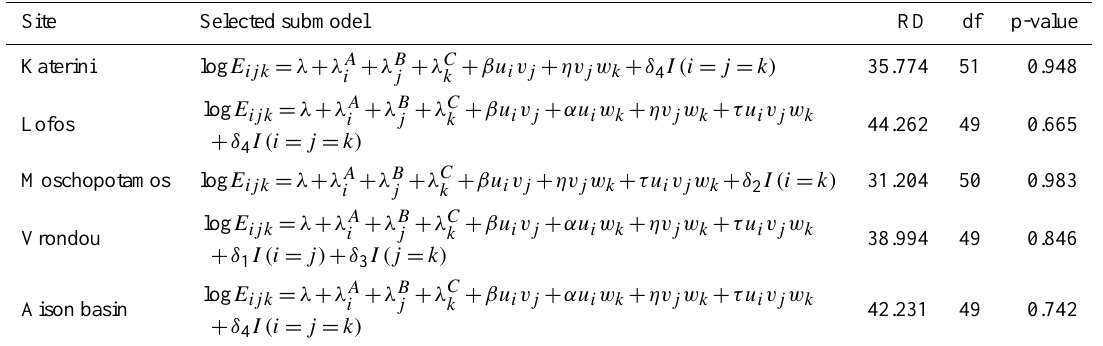
Table 5. Selected loglinear quasi-association submodels for all sites. Site Selected